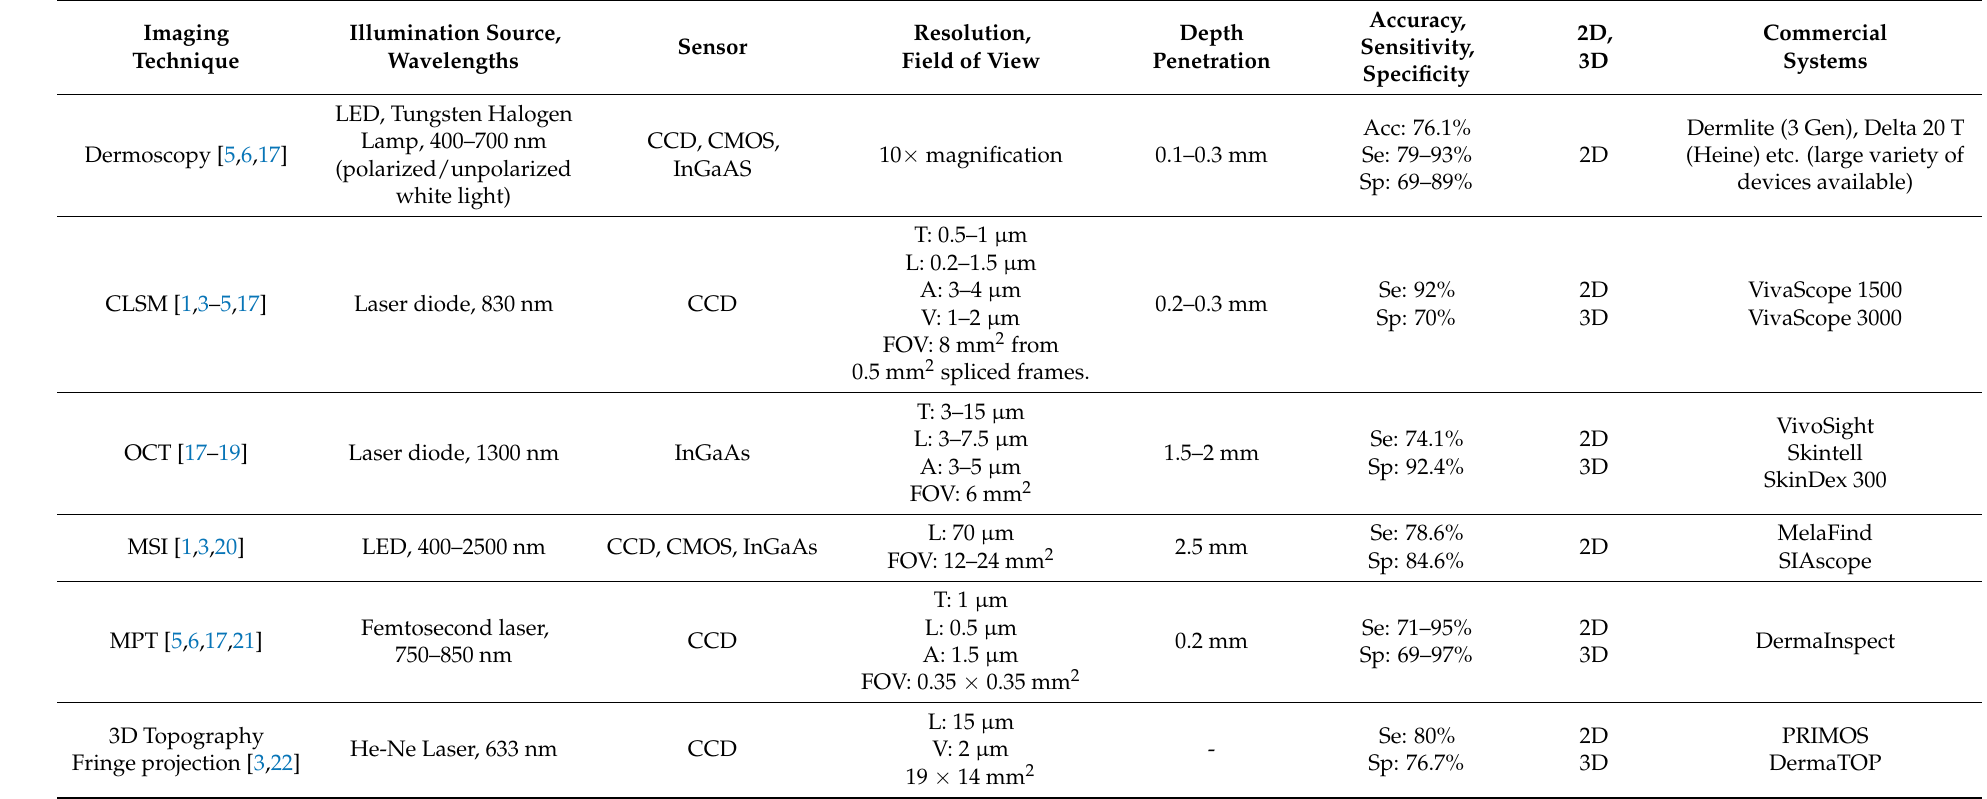
Table 1. Characteristics, performance and availability of imaging techniques developed for melanoma